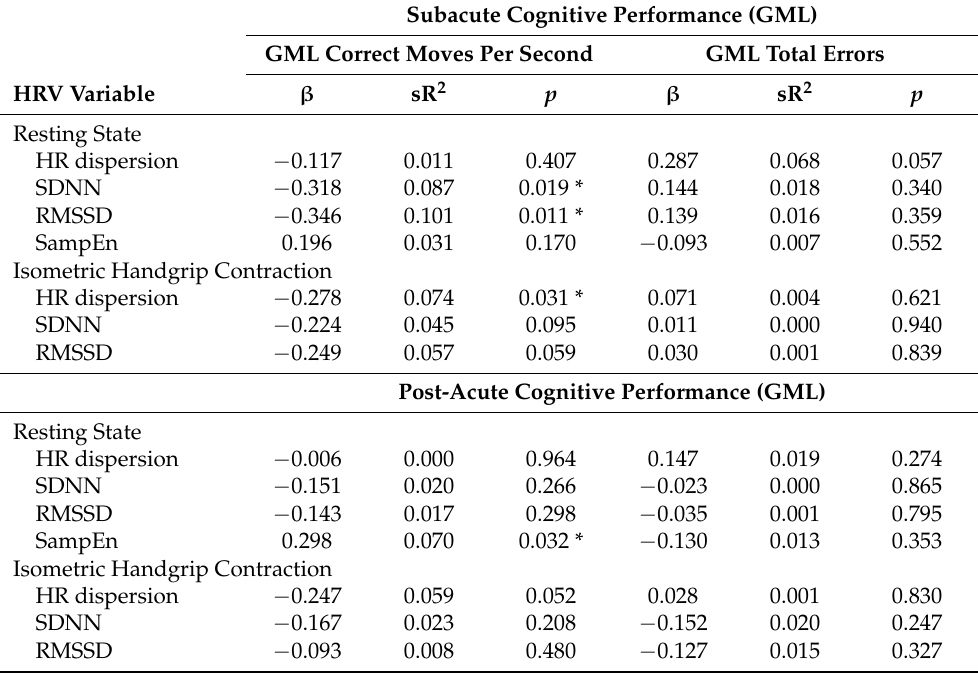
Figure 2. Scatter plots of the unadjusted relationships in the post-acute Behavior Rating Inventory of Executive Function (BRIEF-P) Organization of Materials scales and subacute heart rate variability (HRV) metrics at rest: ( A ) standard deviation of normal-to-normal (NN) intervals (SDNN; β = − 0.255, sR 2 = 0.065, p = 0.061) and ( B ) root mean square of successive NN interval differences (RMSSD; β = − 0.302, sR 2 = 0.091, p = 0.025). Adjusted subacute SDNN ( β = − 0.301, sR 2 = 0.078, p = 0.043) and RMSSD ( β = − 0.345, sR 2 = 0.101, p = 0.021) significantly predicted the post-acute BRIEF-P Organization of Materials scales. Table 7. Multivariate regression analyses for Groton Maze Learning (GML) a